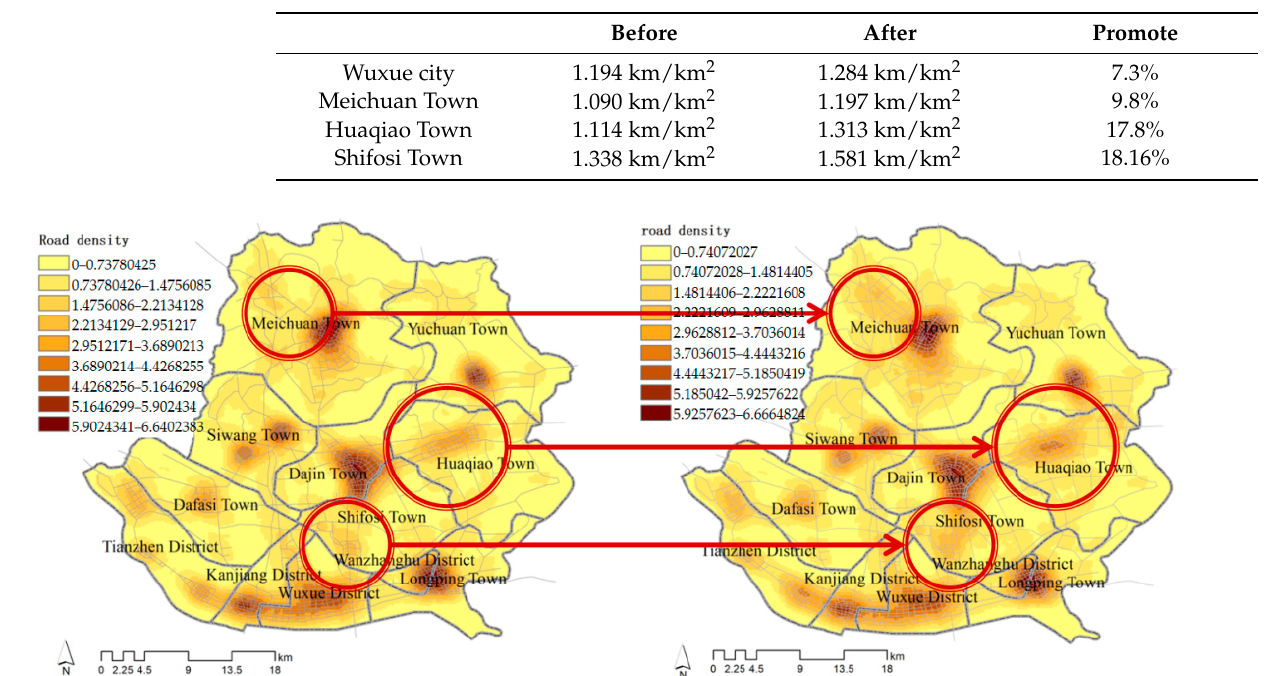
Table 7. Comparison of the density before and after modification.